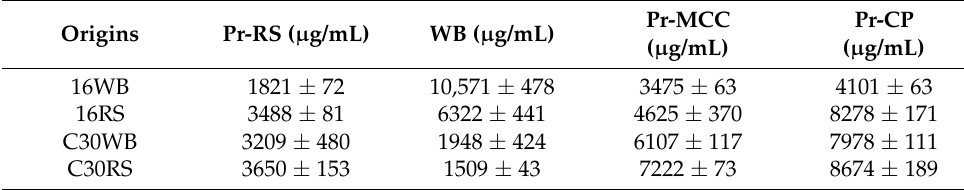
Table 2. Total soluble sugars released from pretreated agricultural wastes for 96